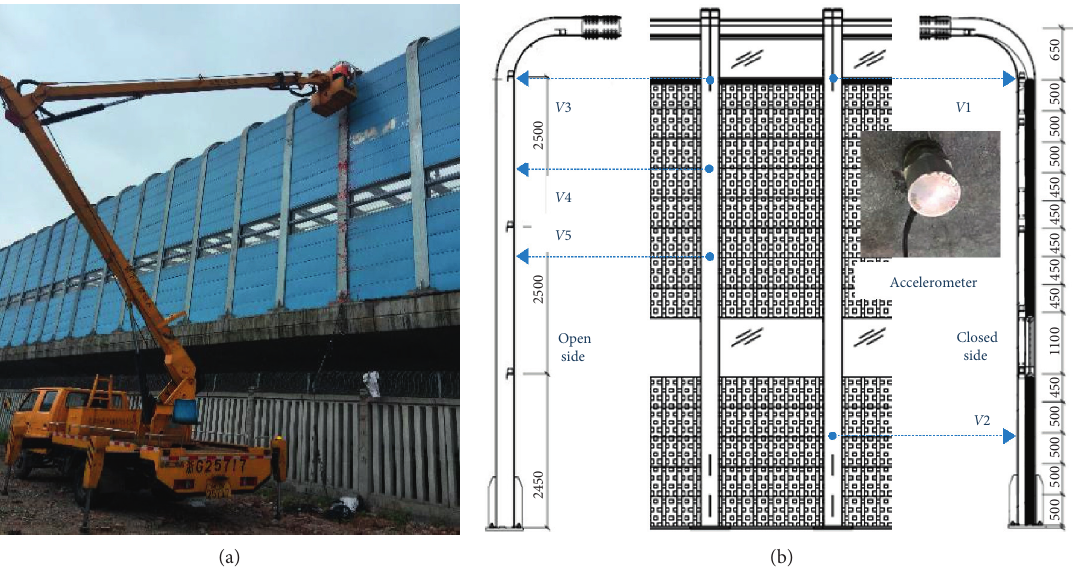
Figure 8: Arrangement of accelerometer: (a) photo of accelerometer arranging; (b) accelerometer distribution on the SESB.